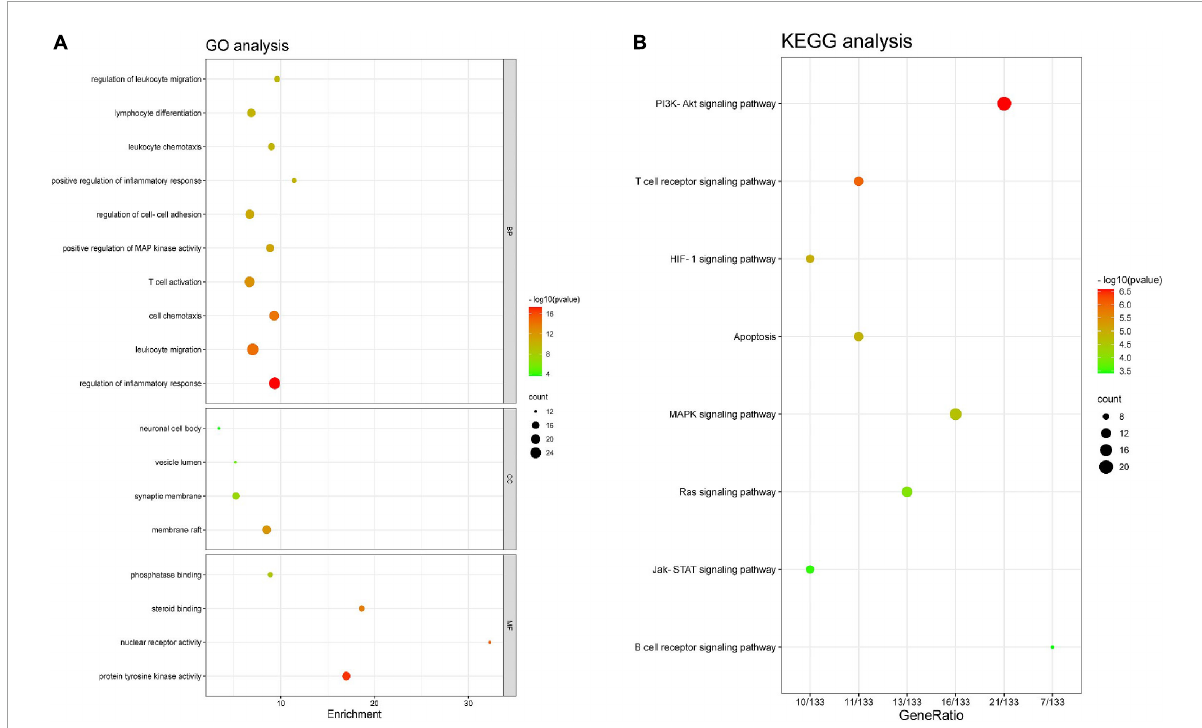
FIGURE4 Enrichment analysis. (A) Gene ontology (GO) functional enrichment analysis. (B) Kyoto Encyclopedia of Genes and Genomes (KEGG) pathway enrichment